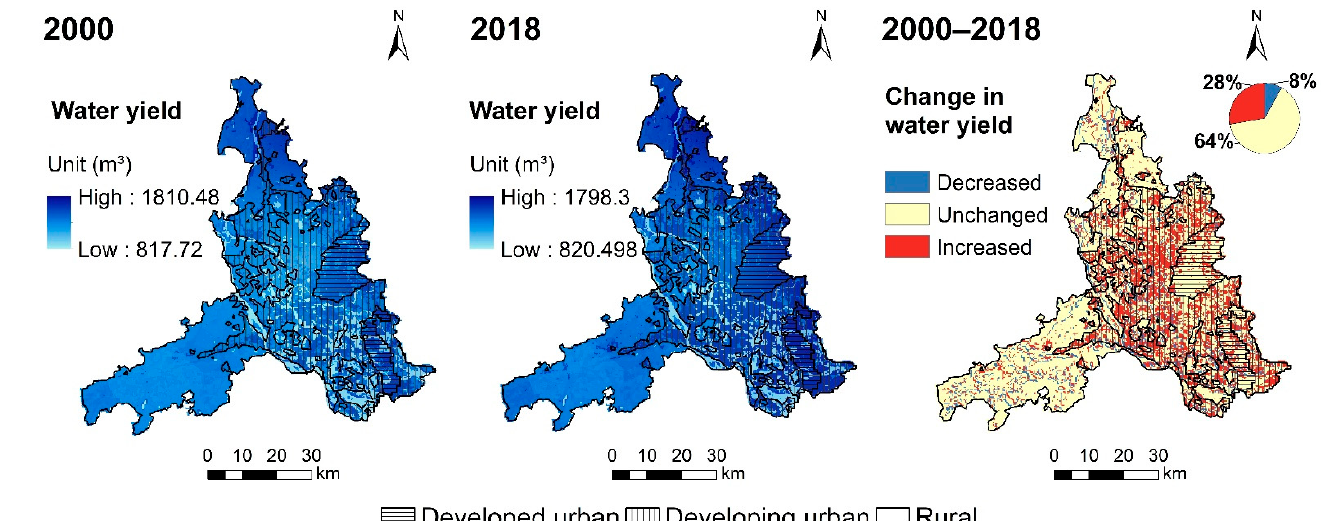
Figure 9. Spatial patterns of water yield in Foshan from 2000 to 2018.